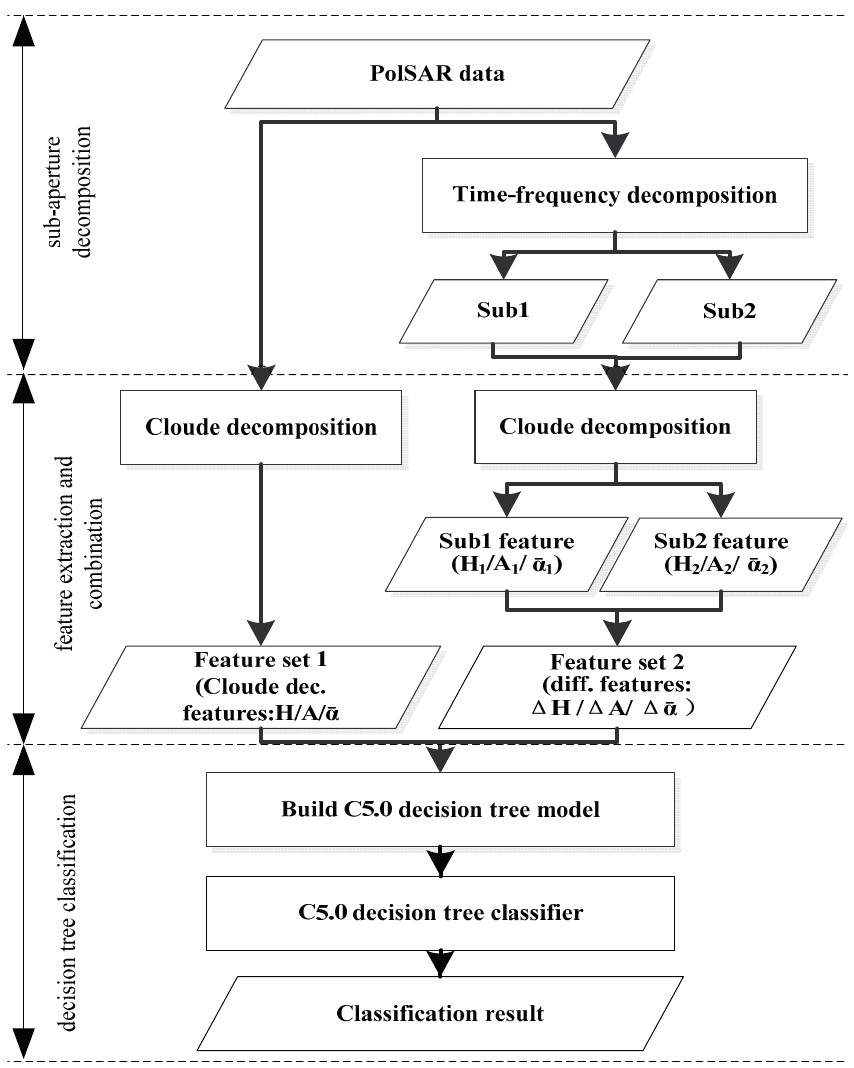
Figure 3. Flow chart of the PolSAR image classification combining with the sub-aperture